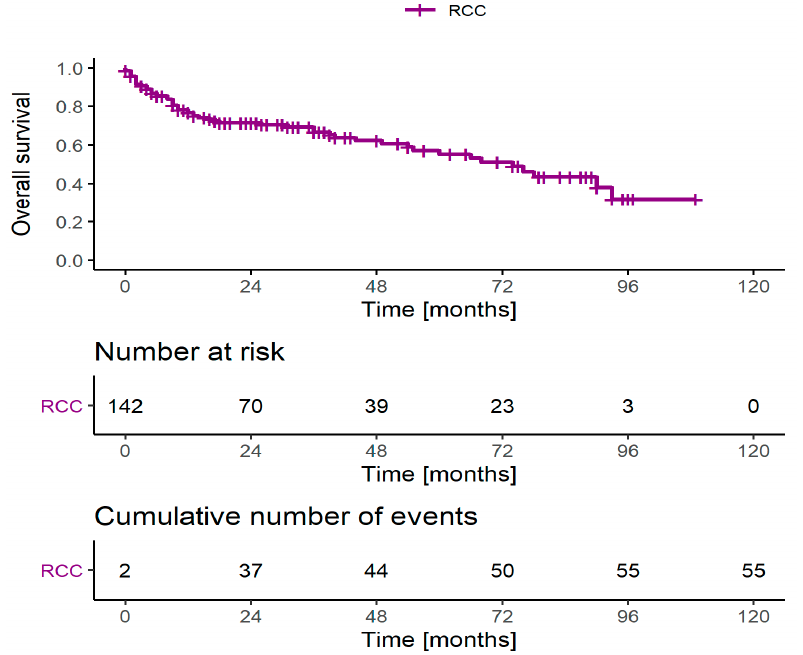
Figure 1. Overall survival for the patients with RCC and tumor thrombus. Abbreviations: RCC: renal cell carcinoma.